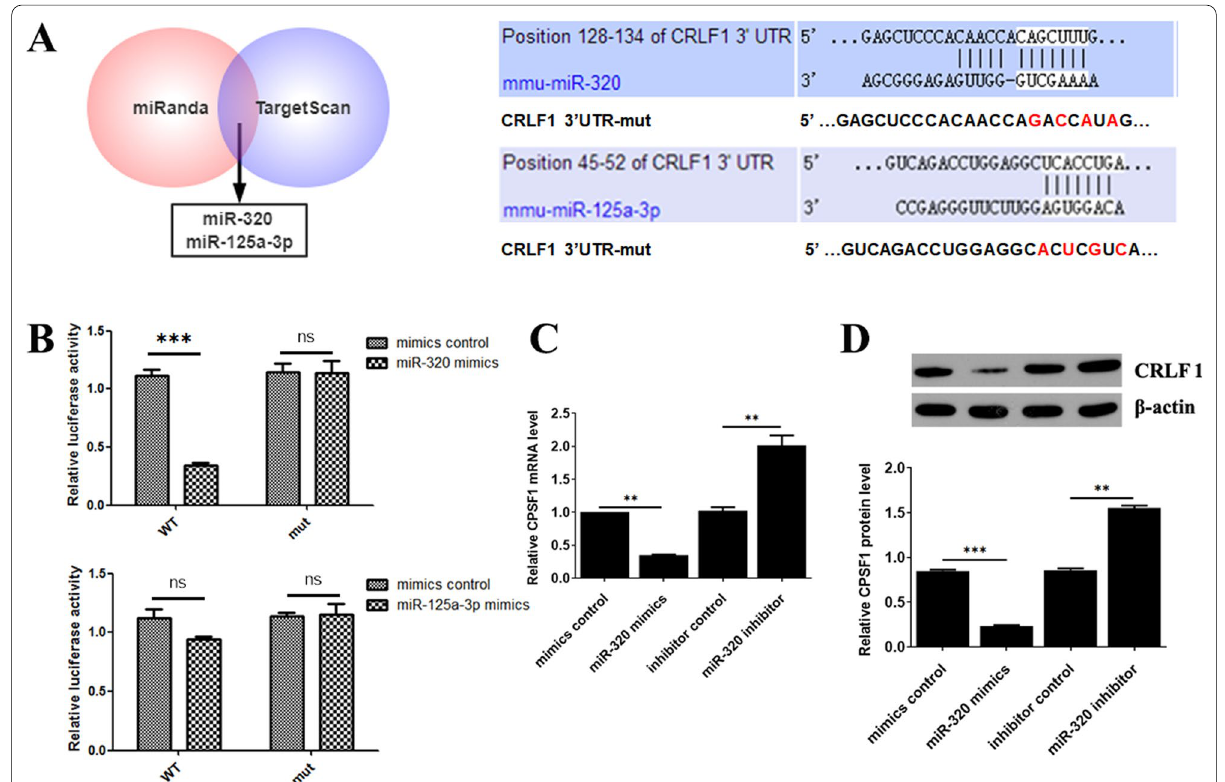
Fig. 4 CRLF1 3 ′ -UTR is the direct target of miR-320 in BMSCs. A Target sequence in the 3’-UTR of CRLF1 predicted to bind miRNA-320 and miR-125a-3p. B Luciferase activity of BMSCs co-transfected with WT or Mut CRLF1 3’-UTR and miRNA-320/miR-125a-3p mimic or inhibitor. C RT-qPCR and D WB measured the effect of miRNA-320 mimic or inhibitor on CRLF1 expression.